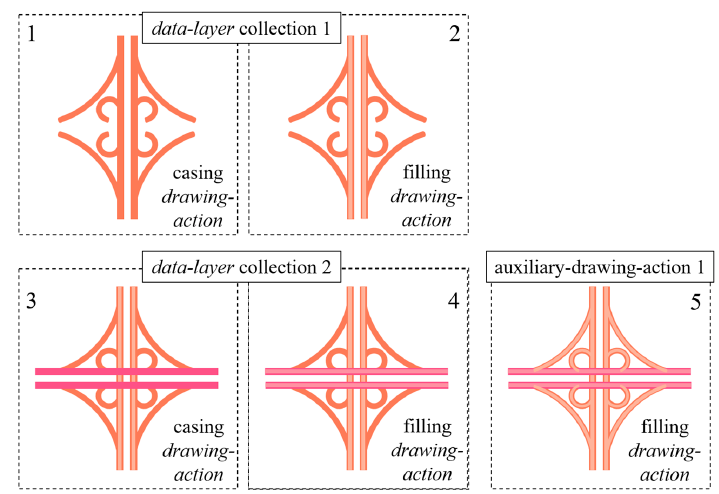
Figure 13. Rendering sequence for road networks with two levels.